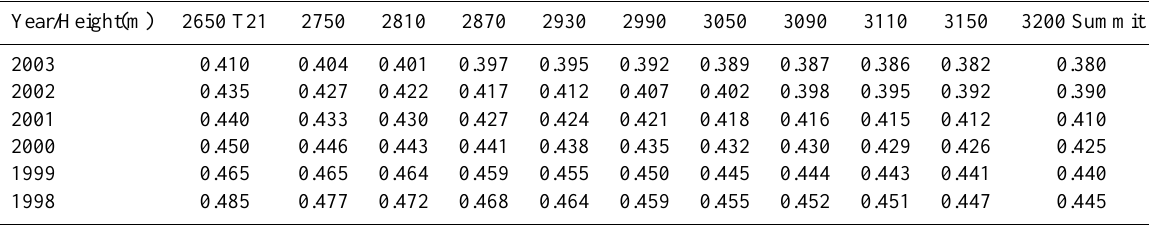
Table 1. Snow and firn density values (gcm − 3 ) for each annual accumulation period and for each altitude where accumulation rate is estimated. Observed annually averaged densities are presented from field data collected at two sites located above (Summit) and below (T21) our